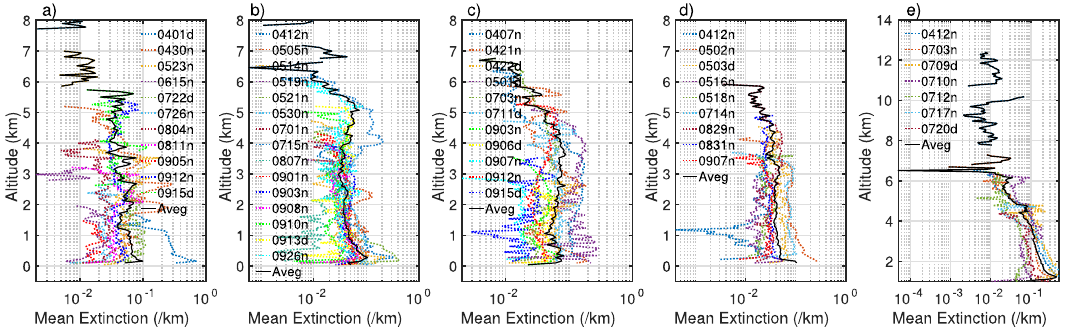
Figure 13. Aerosol extinction coefficient profiles for selected caces with the height above the sea surface level over the following sub-regions: ( a ) the Aral Sea Basin; ( b ) Ustyurt Plateau; ( c ) the Kara Kum Desert; ( d ) the Kyzyl Kum Desert; and ( e ) the Taklimakan Desert. The characters d and n in the legend denote “day” and “night”, respectively.